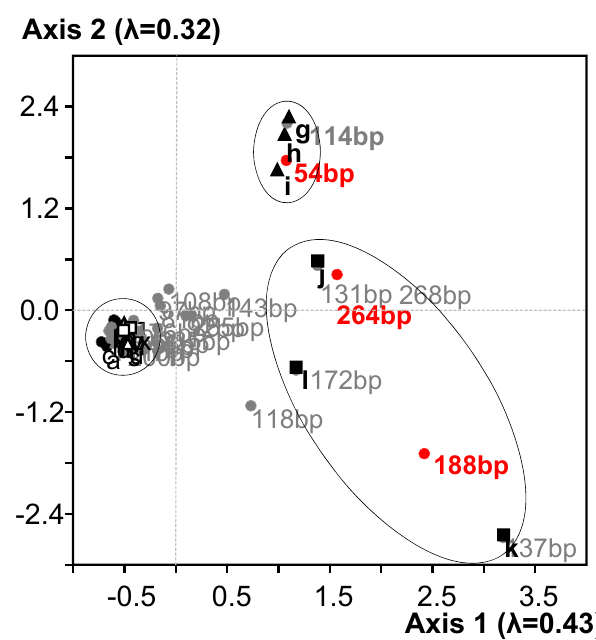
Figure 4. Effect of chitin supplementation on chiA TRF patterns. CCA of TRF patterns of each replicate of the chitin